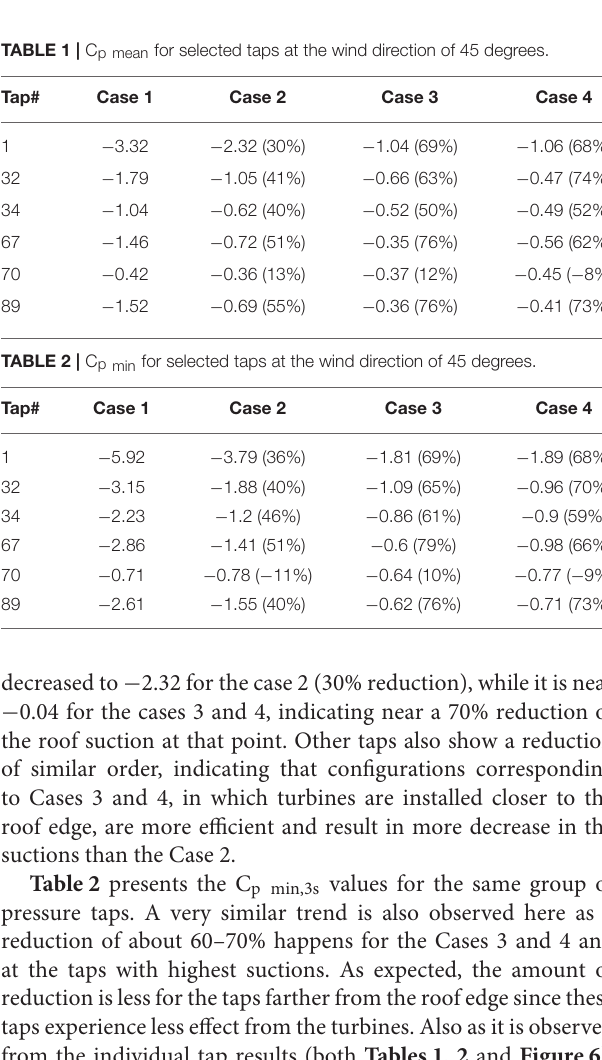
FIGURE 6 | C p min,3s vs. tap numbers for wind direction of 45 degrees.